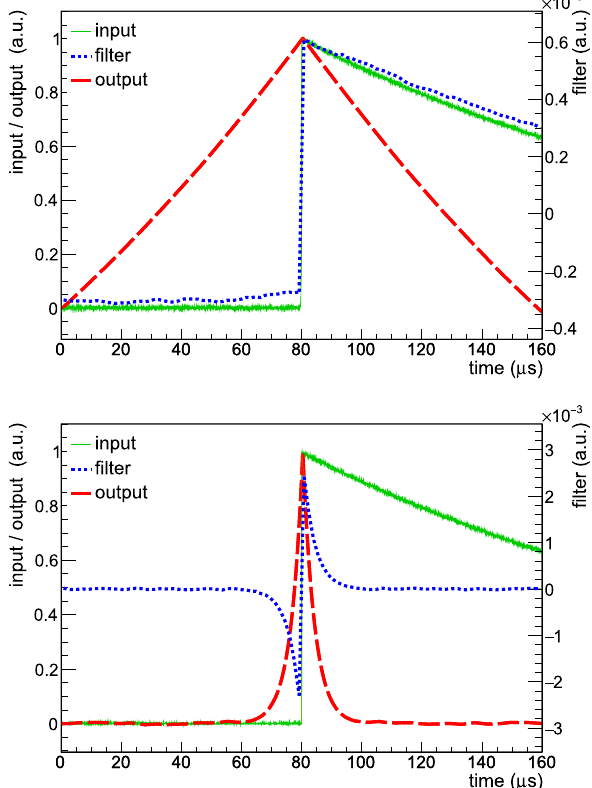
Fig. 9 Filter synthesis results with simulated deterministic waveforms superimposed to series noise (top) and a combination of series and parallelnoise(bottom),withinputsignalshownasgreenlines,optimum filters as blue dotted lines, and output signal as red dashed lines. Input and output signals, sharing the same vertical axis, are normalized to the unity (as for Figs. 10 and 11)